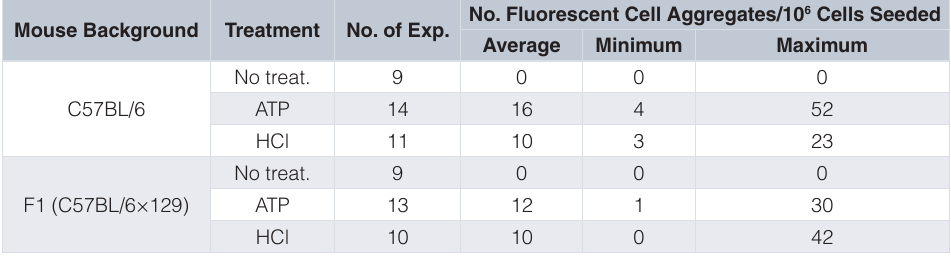
Table 1. Frequency of cell aggregates from oct-gfp transgenic spleen after low pH